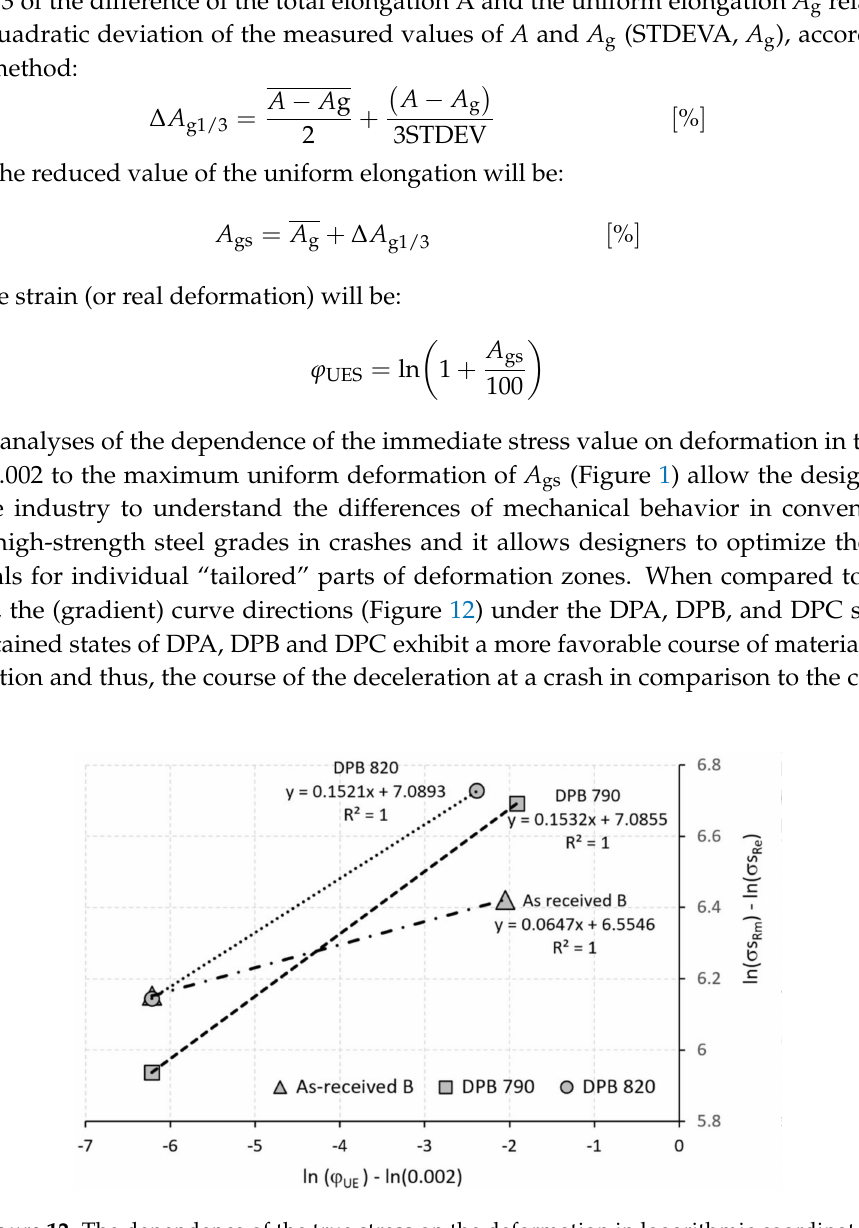
Figure 12. The dependence of the true stress on the deformation in logarithmic